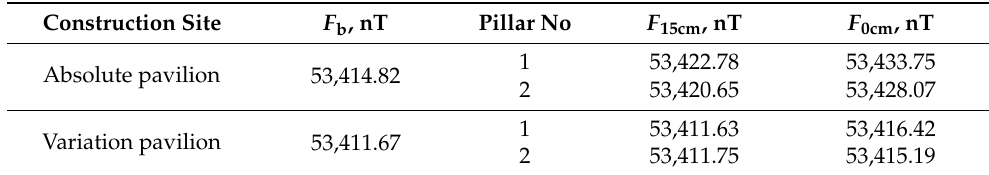
Table 2. Anomalous geomagnetic effects observed near the concrete bases of initially built pillars at the Klimovskaya observatory.